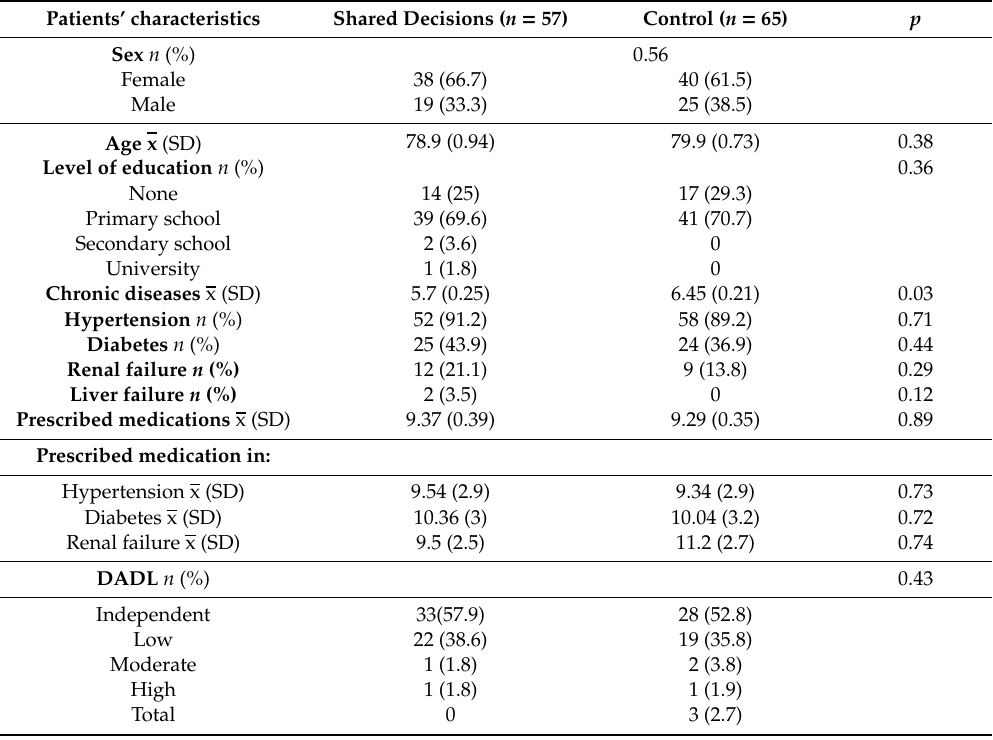
Table 1. Characteristics of the study